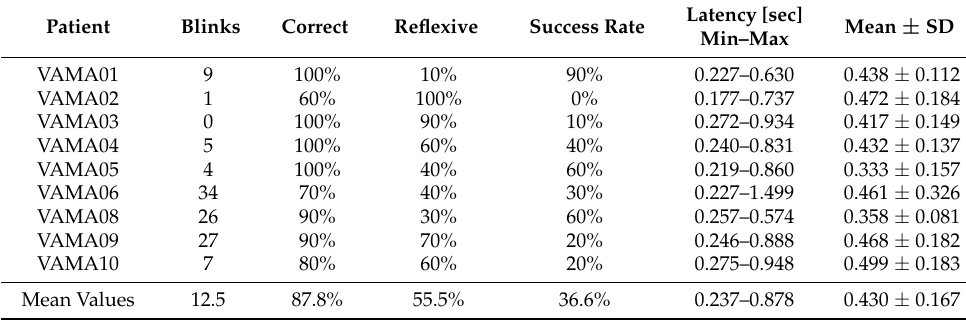
Table 10. Antisaccadic test. Main features in post-COVID-19